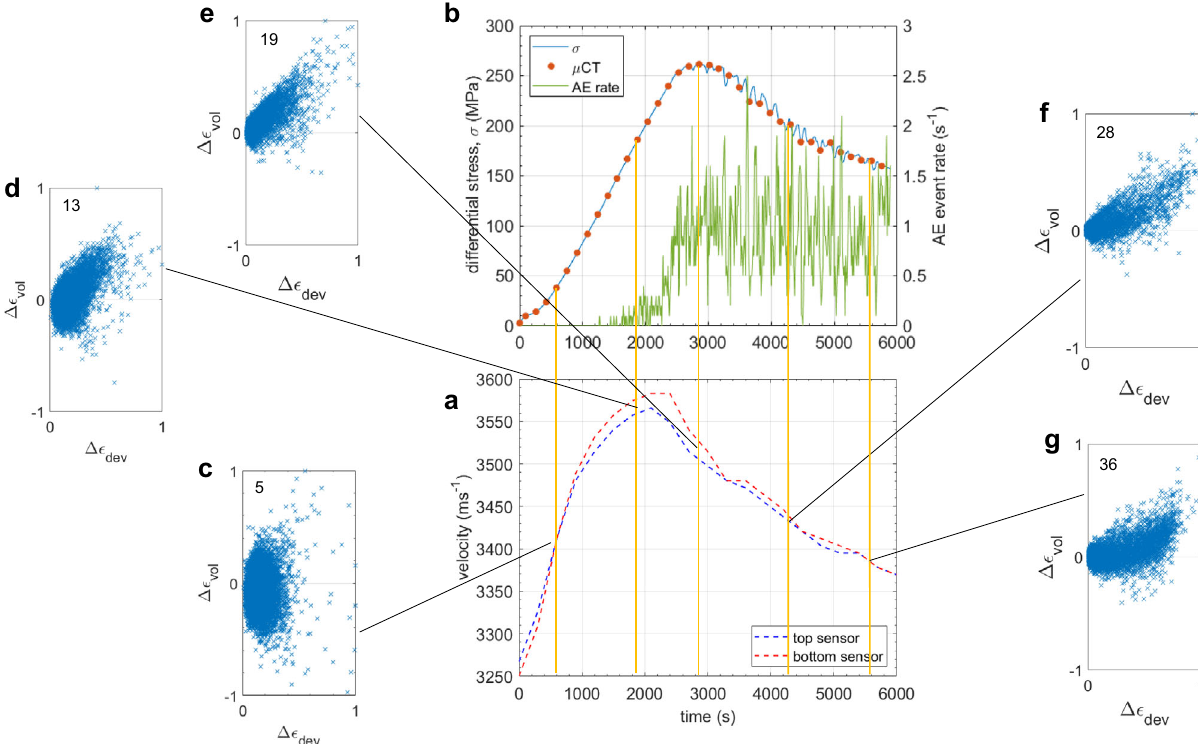
Fig. 4 | Velocity, stress and AE event rate evolution as a function of time, with selected incremental strain fi eld cross-plots. a Velocity evolution, de fi ned from activeseismicsurveys,usingthetopsensorasareceiverwiththebottomsensoras theseismicsource(blueline)vs.thebottomsensorasareceiverwiththetopsensor astheseismic source (red line). b Differentialstress throughout loading (blue line) along with AE event rate (green line). Orange circles denote the times of the X-ray tomographic volumes. c – g Normalised cross-plots of the local incremental devia- toric (shear) strain, 4 ϵ dev , vs. incremental volumetric strain, 4 ϵ vol , showing the